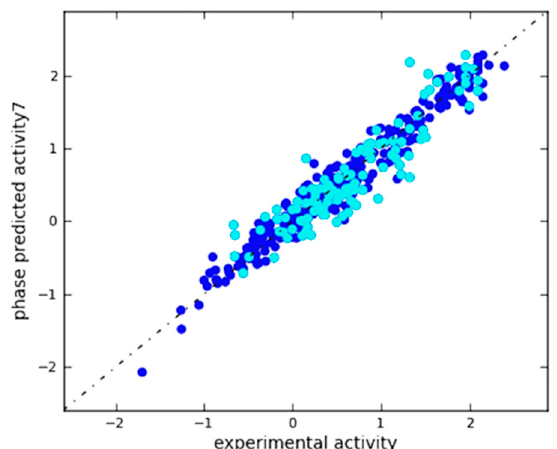
Figure 4. Scatter plot for the predicted (Phase-predicted activity) and the observed (experimental activity) pIC 50 values ( µ M) as calculated by the 3D-QSAR model applied to the training set (blue) and test set (cyan) compounds.